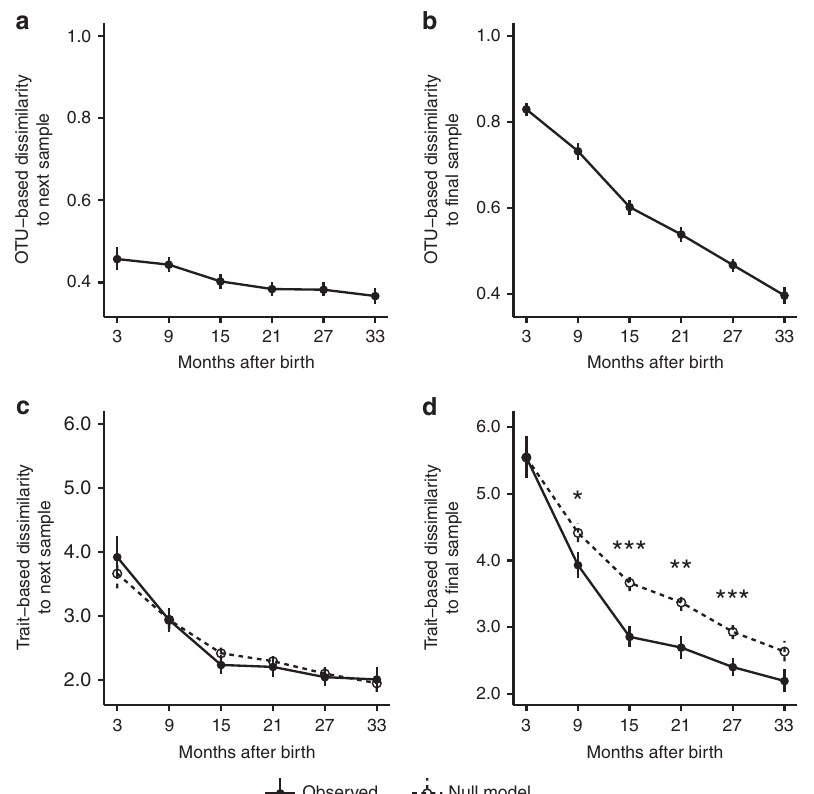
Fig. 4 Trait-based composition stabilizes earlier than taxonomic composition. Filled circles show mean pairwise compositional dissimilarities of gut microbiome samples collected from individual infants, averaged within 6-month periods for each infant, and then across infants. OTU-based dissimilarity was calculated using Bray – Curtis dissimilarity. Trait-based dissimilarity was calculated using multidimensional Euclidean distance after scaling the distributions of values for each trait to ensure equal contribution. a Mean OTU-based dissimilarity between subsequent samples declines slightly over time. b Mean OTU-based dissimilarity between samples and the fi nal samples taken from each infant decreases steadily throughout the sampling period until fi nally reaching baseline levels of between-sample dissimilarity in the last 6-month period, seen in a . c Mean trait-based dissimilarity between subsequent samples appears elevated in the fi rst year, but does not differ signi fi cantly from null model predictions that assume trait-agnostic turnover (see Methods). d Mean trait-based dissimilarity between samples and the fi nal samples taken from each infant decreases rapidly and approaches baseline levels of between-sample dissimilarity within the fi rst year, seen in c . Moreover, trait-based community composition converges toward that of the fi nal sample signi fi cantly faster than null model expectations, illustrating the non-random nature of trait-based community turnover over succession. In all panels, N equals 56, the number of infants. Vertical lines show 95% con fi dence intervals. Asterisks denote signi fi cance between observed and null model predictions based on Welch t tests (* p < 0.05; ** p < 0.01; *** p <